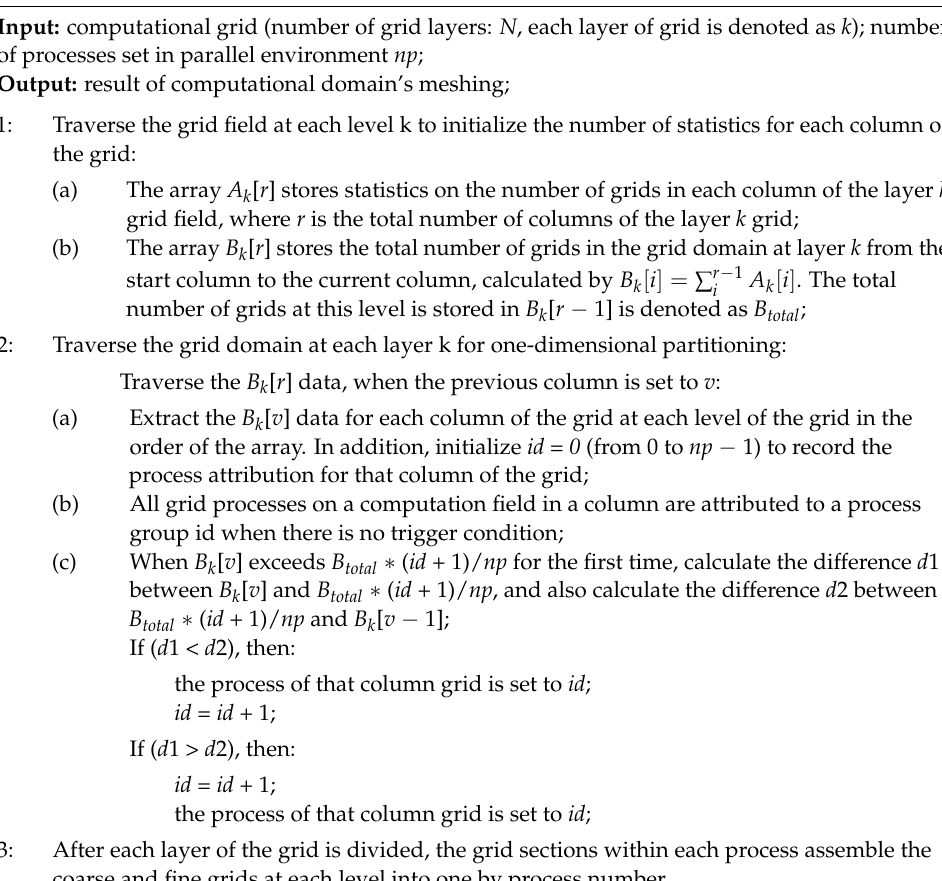
Algorithm 1 Multi-layer grid-meshing algorithm based on load